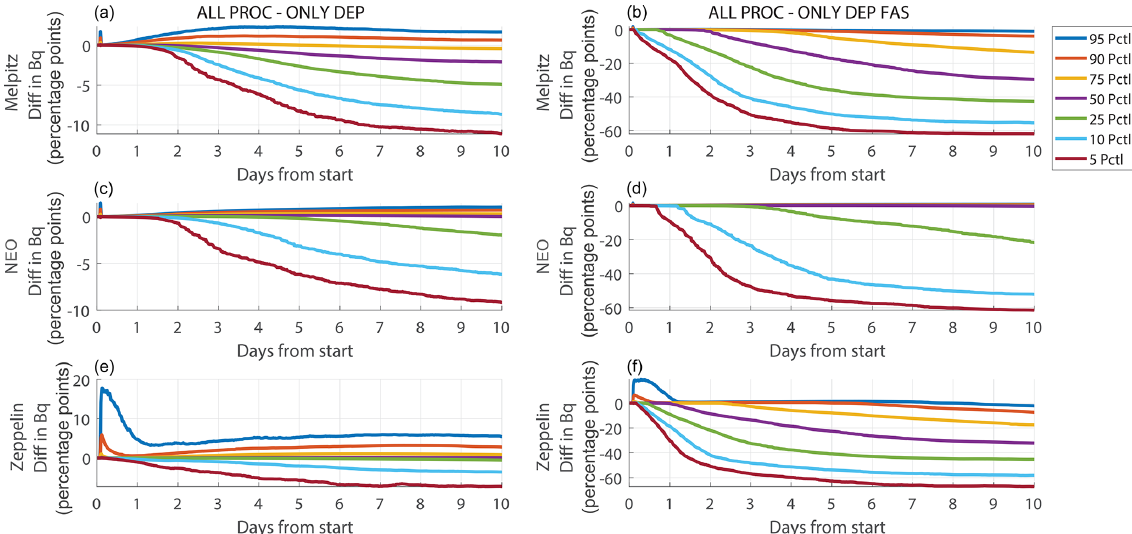
Figure 9. Difference in percentage points for the total caesium concentration for two different experiments. Percentile (Pctl) values over the 10d period. ALL PROC minus ONLY DEP (a, c, e) and ALL PROC minus ONLY DEP FAS (b, d, f) . Panels (a, b) are for Melpitz; (c, d) are for NEO; and (e, f) are for Zeppelin. Negative values represent when ALL PROC has lower concentration than the compared experiment (ONLY DEP on the left and ONLY DEP FAS on the right), i.e. when advanced aerosol dynamics yield lower air concentrations. Note that the scales of the y axes vary between the